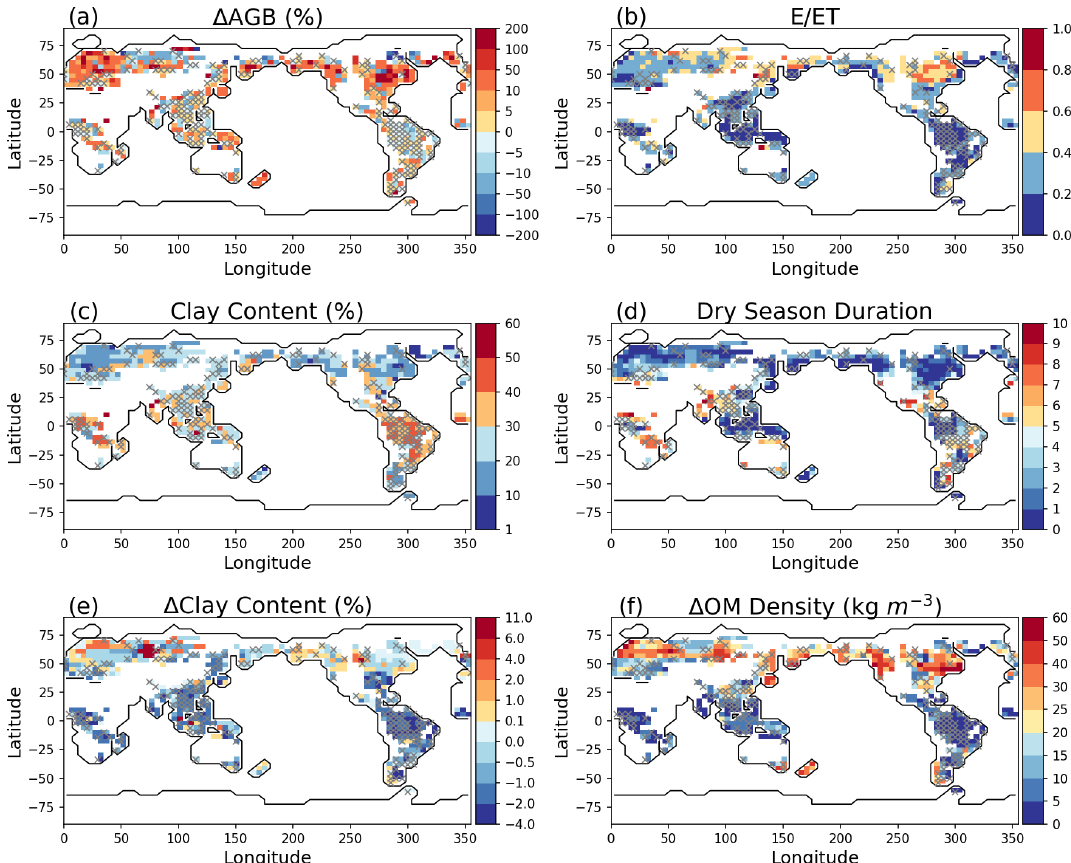
Figure 4. Model differences resulted from layer aggregations: percent change of AGB (Experiment − Reference) (a) , E / ET (b) for simula- tion year 100, average clay content in the soil column (c) , dry-season durations (months) (d) , clay content difference (e) , and organic matter difference (f) between layer 1 and the average of the top five layers from the surface. The pixels in white on land have values beyond the limits of the legends, associated with AGB < 0 . 5gCm − 2 . Pixels with symbol × have AGB differences less than